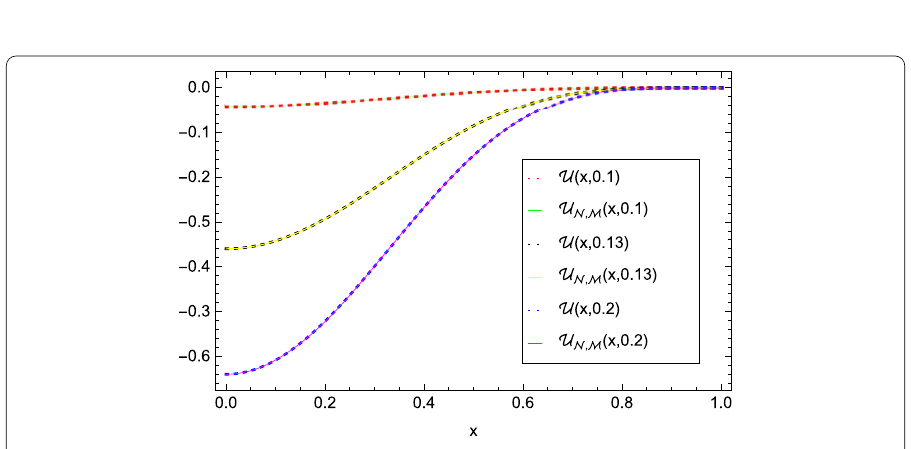
Figure 8 x -direction curves of U and U N , M of problem (3), where δ = 1.8, N = 10, M =